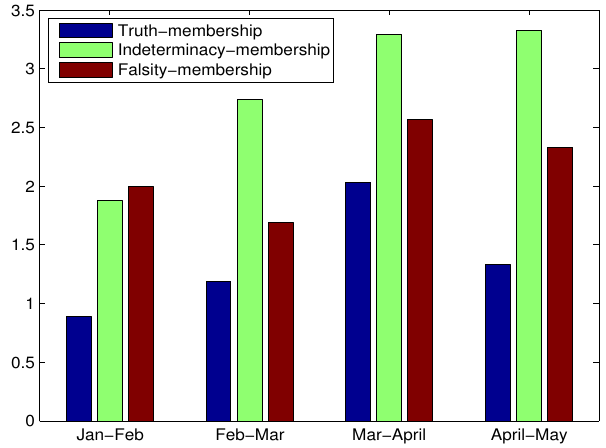
Figure 12. Single-valued neutrosophic graph Figure 12: SVNG